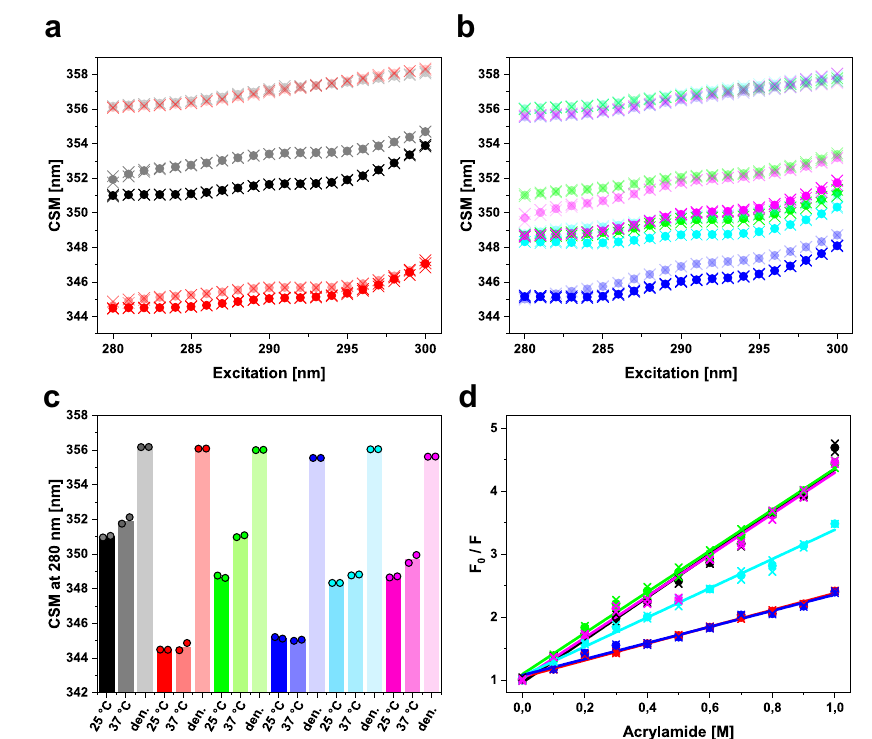
Fig. 3 REES fl uorescence and acrylamide quenching give insights into folding and conformational fl exibility. a REES data of P-CL (black) and G-CL (red) at 25 °C (solid), 37 °C (light coloring), and in the presence of 6 M urea (very light coloring; data points at the top). The CSM value at 280 nm indicates solvent exposure of the tryptophan fl uorophores. Mean values are shown as dots, and individual data points are shown as crosses. b REES data of P-LC (green), G-LC (blue), P-LC G136V (cyan), and G-LC V136G (magenta). Data at 25 °C are shown as solid dots, data at 37 °C as light dots, and data with 6 M urea in very light coloring (points at the top). Individual data are shown as crosses. c Bar graph of the CSM values at 280 nm for all constructs under the three conditions tested. The data in the presence of 6 M urea is termed den. for “ denatured ” . Coloring according to ( a ) and ( b ). The bars represent the mean value, individual data points are shown as circled dots. d Acrylamide quenching plots showing F 0 /F as a function of acrylamide concentration, where F 0 is the native fl uorescence. Coloring is the same as in ( a ), ( b ), and ( c ). Mean values are shown as dots, and individual data points are shown as crosses. The slope of the linear fi t represents the Stern – Volmer constant k sv (Table 2). For G-LC V136G (magenta), the data point at 0.5 M was excluded from the fi t. The fl uorescence data are derived from two independent experiments ( n = 2). Source data are given in the Supplementary Data fi